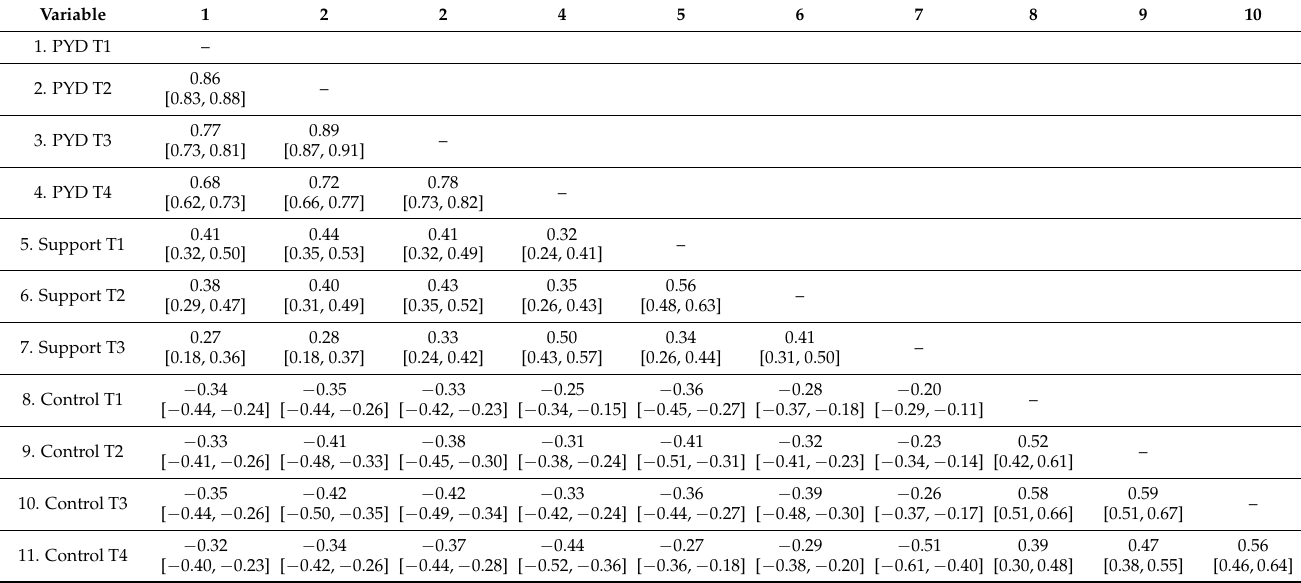
Table 1. Within and over time bivariate correlations between Positive Youth Development and perceived parental behavior. Variable